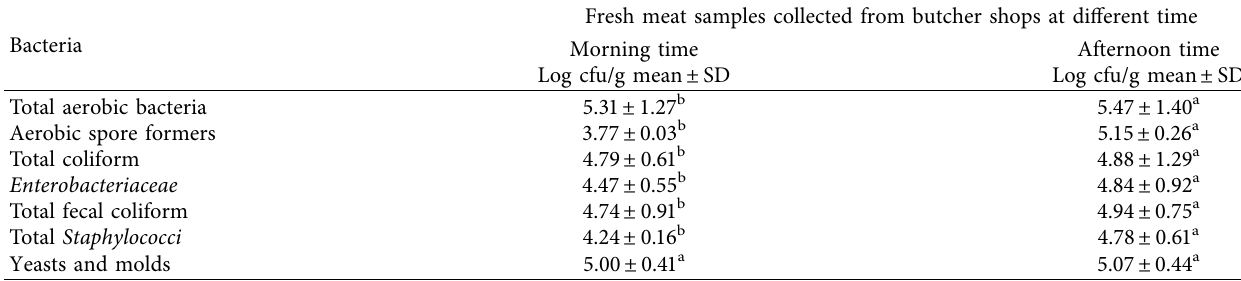
Table 4: Microbial count in fresh beef meat from butcher shops (collected during morning and afternoon time) expressed in log 10cfu/ g ± standard deviation.